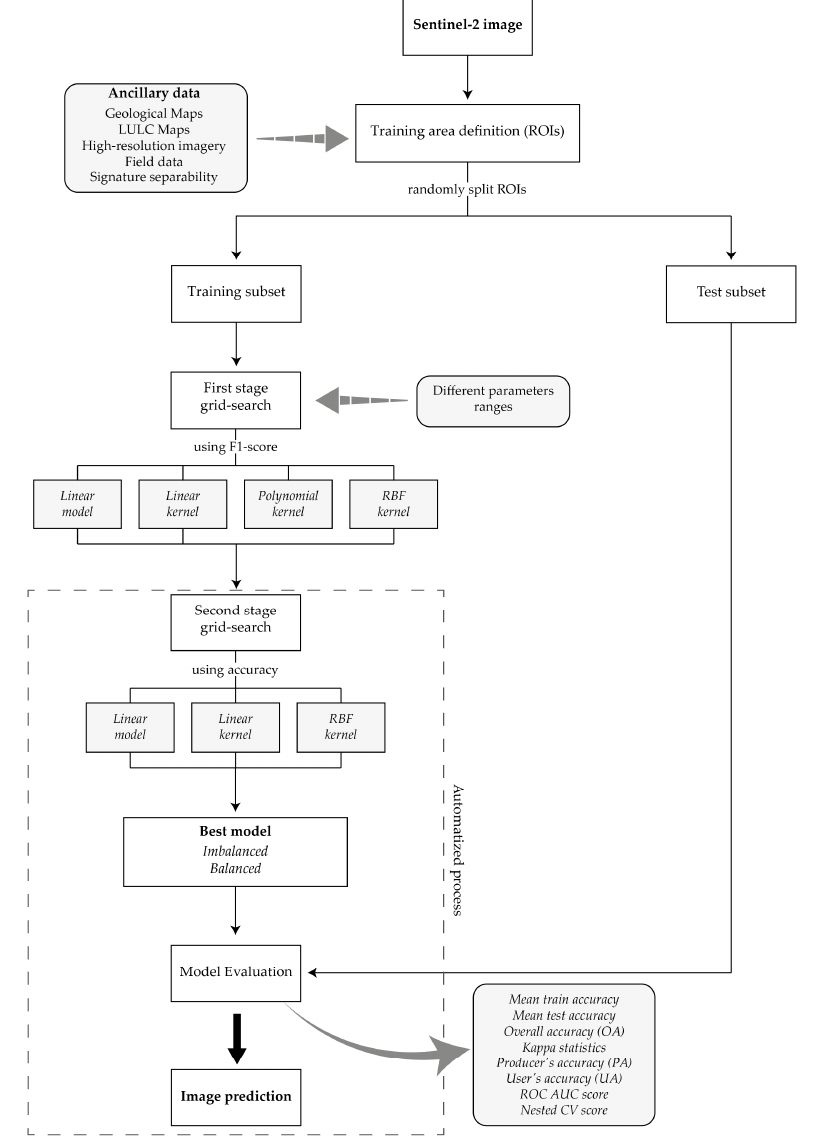
Figure 4. Flowchart of the image classification process.